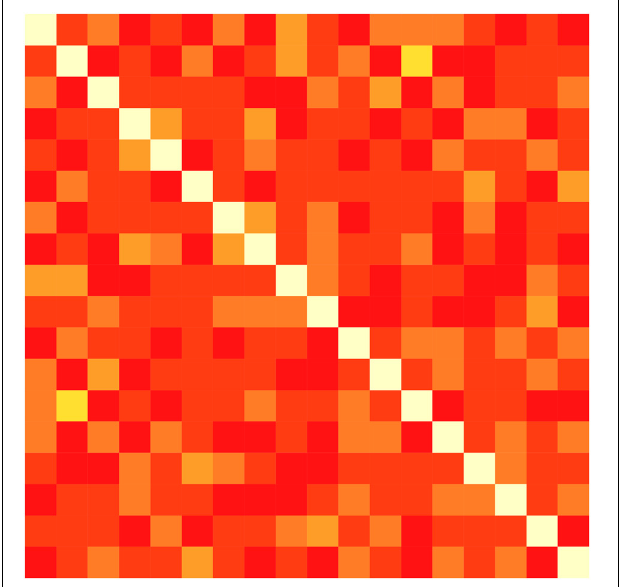
FIGURE 1 | Word × Referent matrix with the co-occurrences of each of the 18 words and objects accumulated across the 27 training trials used in each condition for both